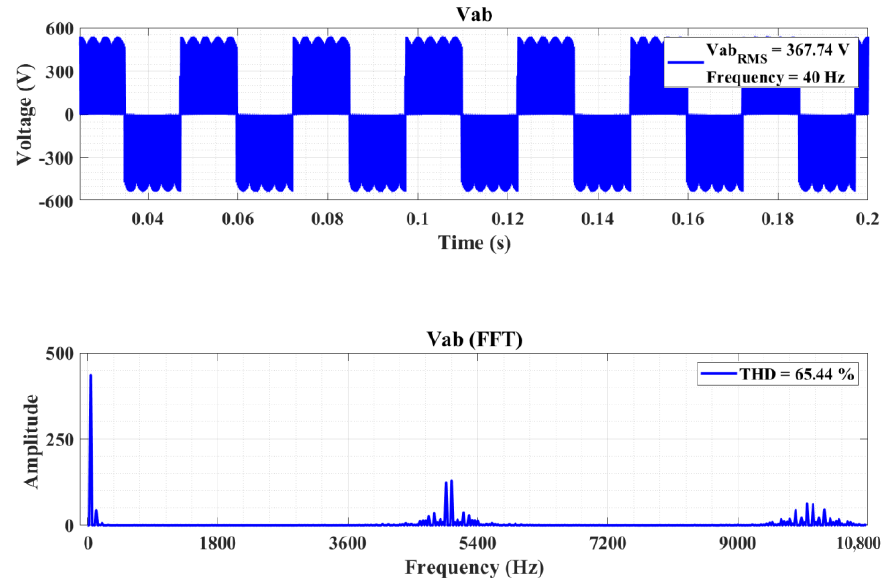
Figure 4. Line voltage and CMC harmonic spectrum.